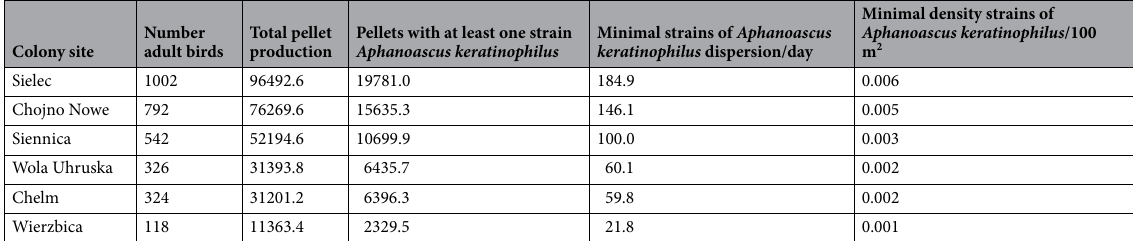
Table 2. Estimation of the Aphanoascus keratinophilus minimal strain dispersion and the minimal density of strains per 100 m 2 area most intensively used by rooks around colonies.